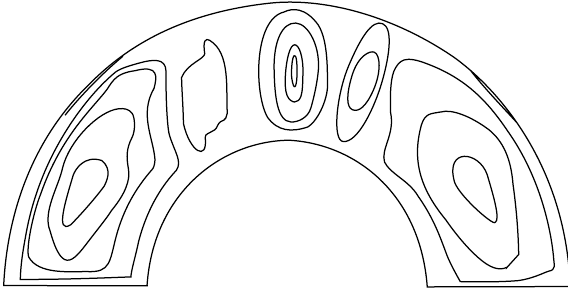
Figure 4.9. Asymmetric Taylor vortex at Re =